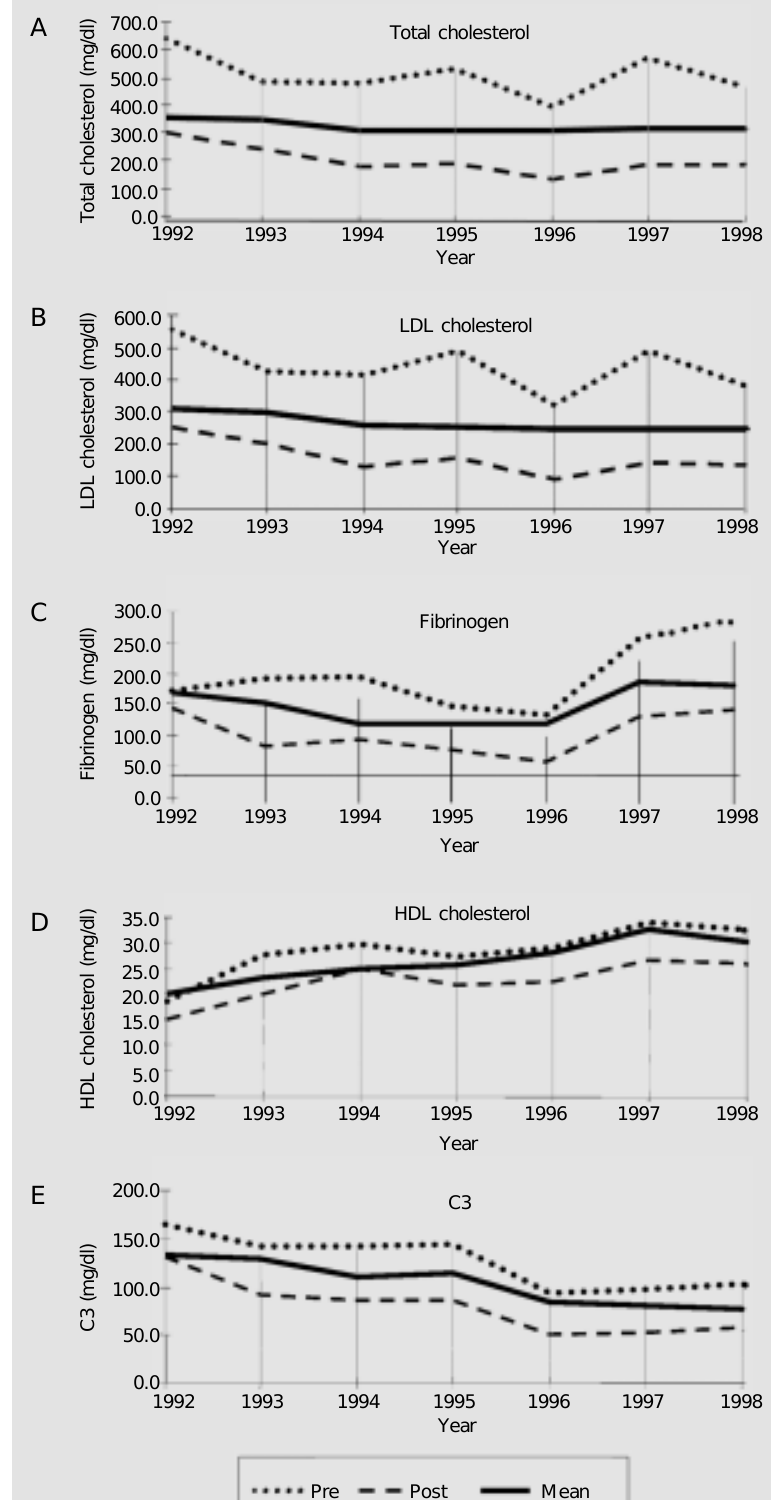
Figure 3. Levels of plasma components before, after and between HELP treatment. A , Total cholesterol; B , LDL cholesterol; C , fibrinogen; D , HDL cholesterol; E , C3. Data are reported as mean